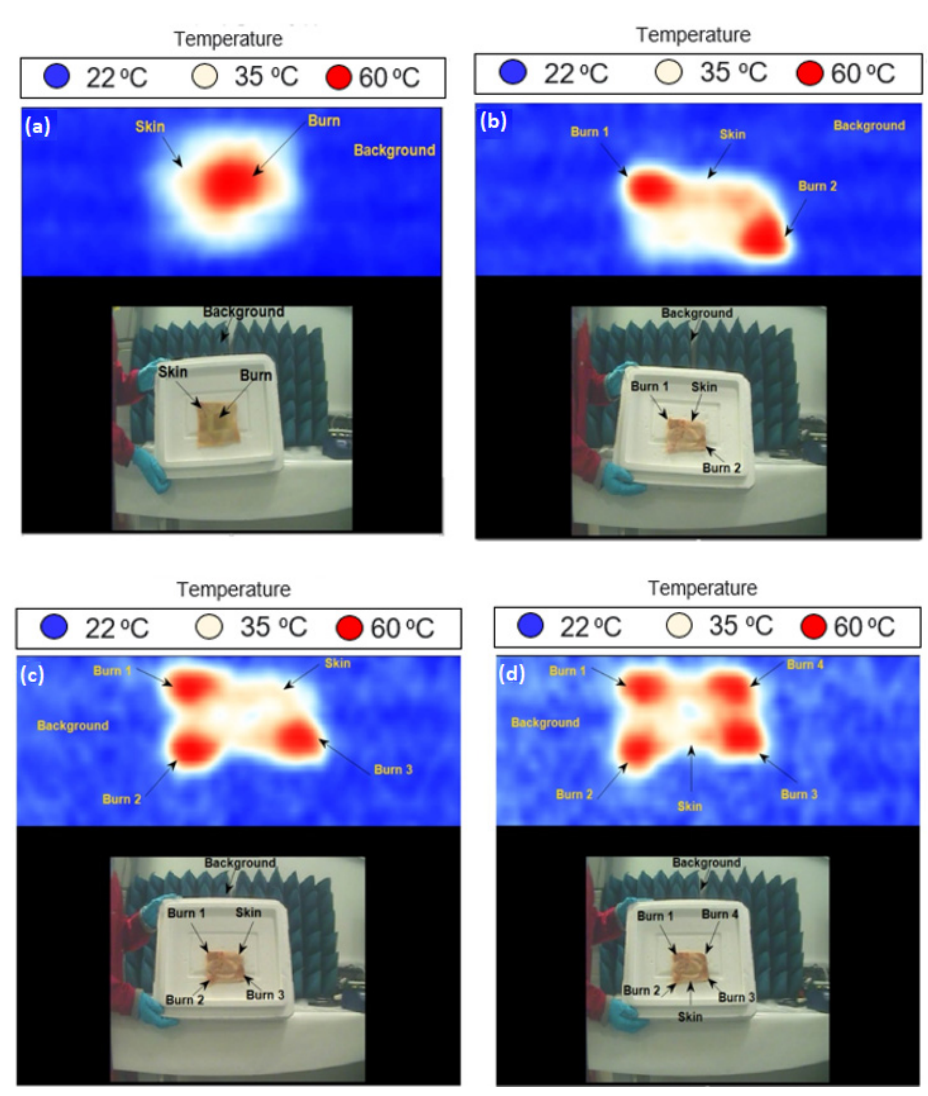
Figure 8. MMW images for porcine skin samples at 250 GHz; ( a ) represents the skin with one burn, ( b ) represents the skin with two burns, ( c ) represents the skin with three burns, and ( d ) represents the skin with four burns. Each image has 229 (w) × 277 (h) pixels, and it takes 5 s to take a screenshot of an image.